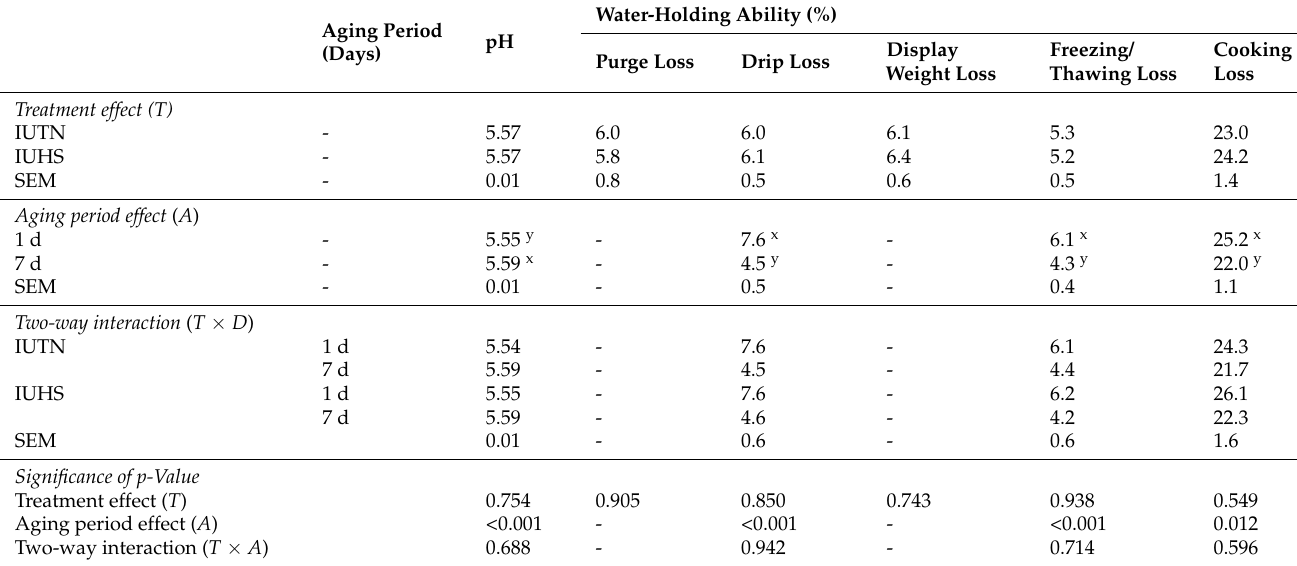
Table 3. Main and interactive effects of IUHS treatment and postmortem aging duration on pH and water-holding ability of pork loin muscle ( n = 10/treatment).